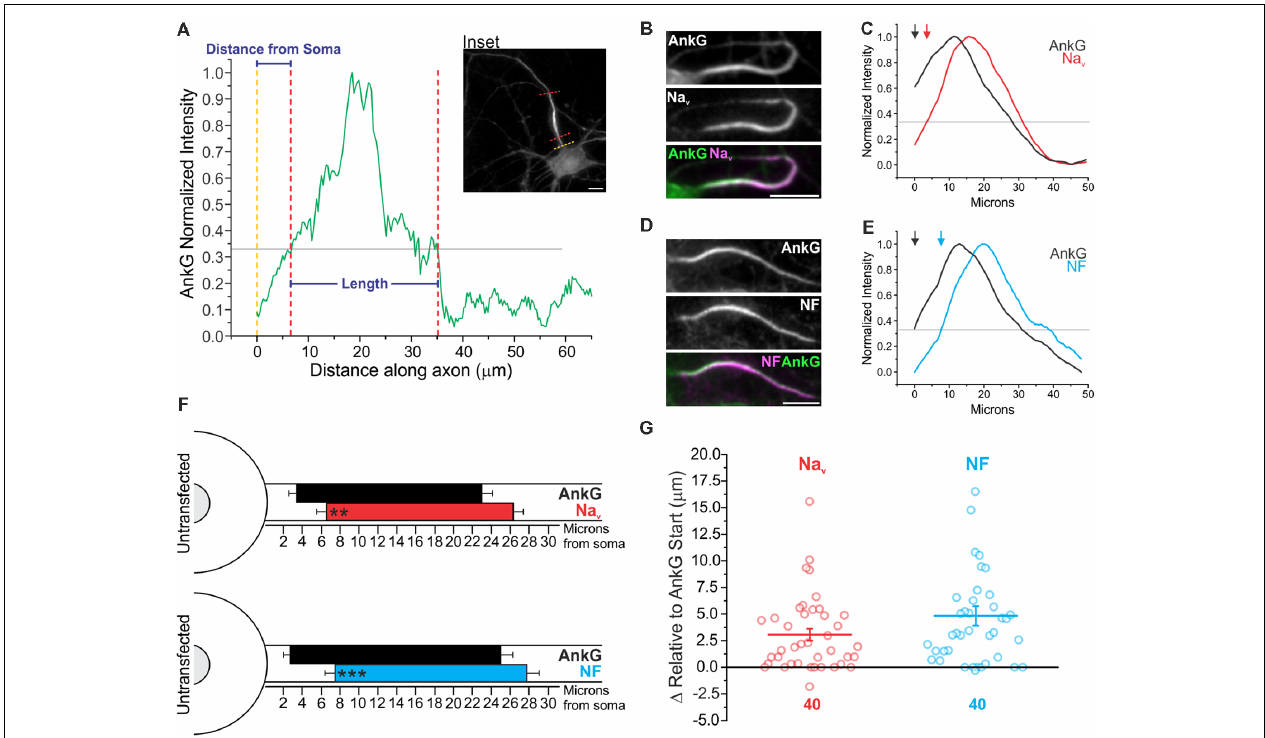
FIGURE 2 | AnkG enriches proximally relative to its binding partners at the AIS. (A) Representative AIS intensity plot for AnkG staining along the proximal axon (see inset) indicating parameters obtained (distance from the soma and length). Gray line indicates the standard 0.33 normalized intensity threshold to define the AIS. Yellow dashed line indicates the junction of the soma and axon where intensity profiling began; red dashed lines indicate start and end parameters of the AIS found as described in the “Materials and Methods” section. Scale bar: 10 µ m. (B) Representative images of immunostaining for AnkG with panNa v . AnkG and Na v are pseudo-colored green and magenta in overlay for contrast. Scale bar: 10 µ m. (C) Smoothed and normalized fluorescence intensity traces for AnkG (black) and Na v (red) from the images in (B) . Gray line indicates fluorescence intensity threshold to define the AIS. Arrows indicate start of AnkG (black) or Na v (red) enrichment above threshold. (D) Representative images of immunostaining for AnkG with NF. AnkG and NF are pseudo-colored green and magenta in overlay for contrast. Scale bar: 10 µ m. (E) Smoothed and normalized fluorescence intensity traces for AnkG (black) and NF (cyan) from (D) . Gray line indicates intensity threshold to define the AIS. Arrows indicate start of AnkG (black) or NF (cyan) enrichment above threshold. (F) To-scale distribution of AnkG (black; n = 40) and Na v (red; n = 40; top), or AnkG (black; n = 40) and NF (cyan; n = 40; bottom) enrichment in untransfected DIV14 neurons. Left error bar indicates SEM for distance from the soma, right error bar indicates SEM for length. Asterisks indicate significance from AnkG start; ∗∗ p = 0.0035 for Na v and ∗∗∗ p < 0.001 for NF, Wilcoxon signed-rank test. (G) Comparison of start of protein enrichment for Na v (red) or NF (cyan) relative to AnkG start (black horizontal line) in the same cells. Error bars indicate mean ± SEM, n = 40 for both